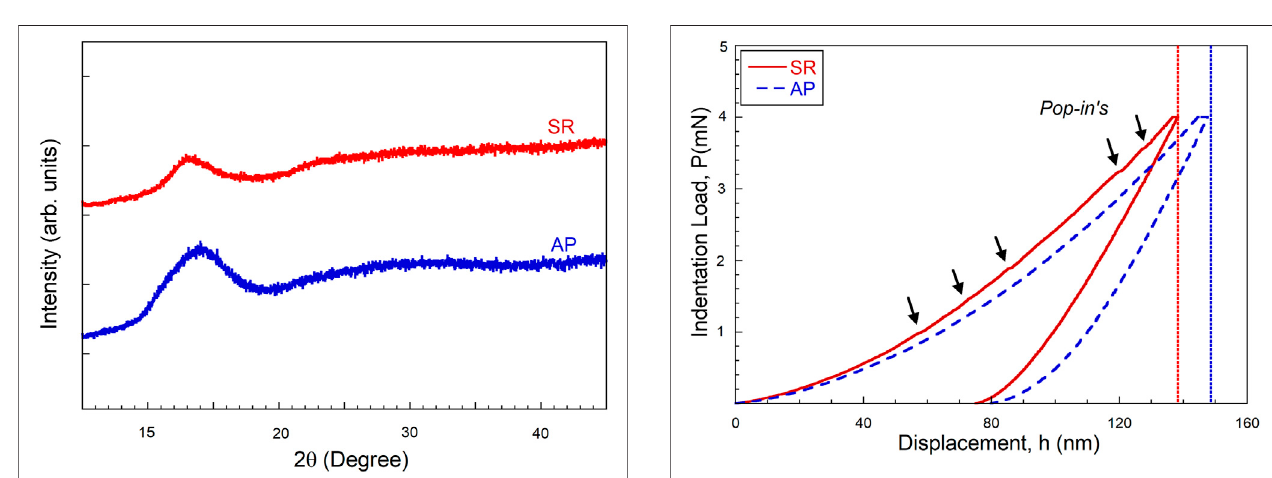
FIGURE2| Representativeindentationload, p ,vs.penetration depth, h , curves of the SR and AP NGs obtained at a P max of 4 mN.